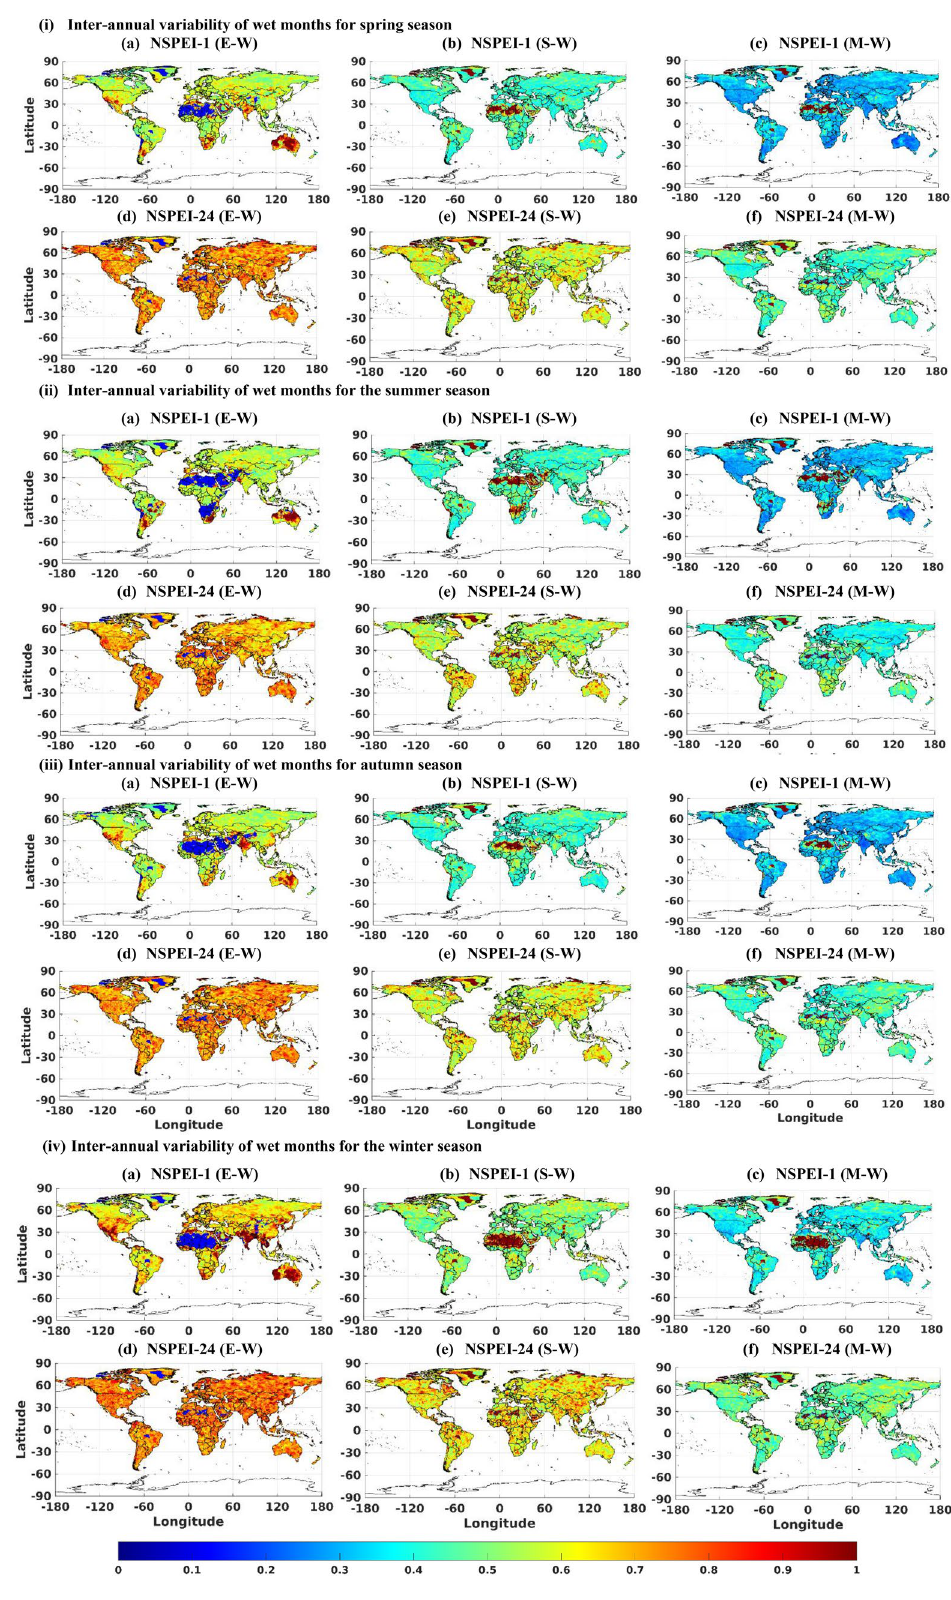
Figure 2. Inter-annual variability (SVI ME ) of the variability of dry conditions in different seasons ((i) spring, (ii) summer, (iii) autumn and (iv) winter) during the period 1901 to 2019. In the notation NSPEI- M , M indicates the accumulation period (AP) in months. Extreme, severe and moderate-intensity levels of dry conditions are denoted by E-D, S-D, M-D, respectively. *The maps were generated using MATLAB (version: